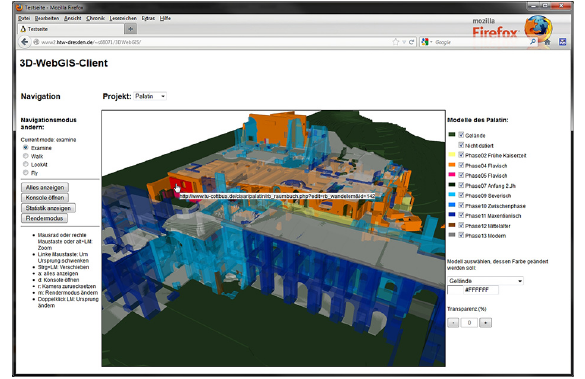
Figure 5: Prototype of the 3D client with the complete building model of the Domus Severiana on Palatine in